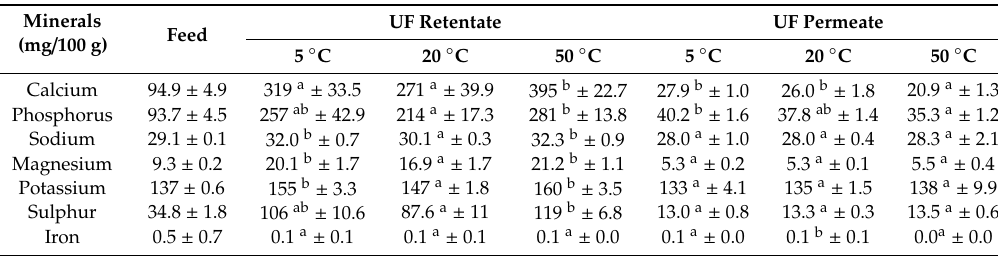
Table 2. Profile of individual minerals in retentates and permeates obtained by ultrafiltration of